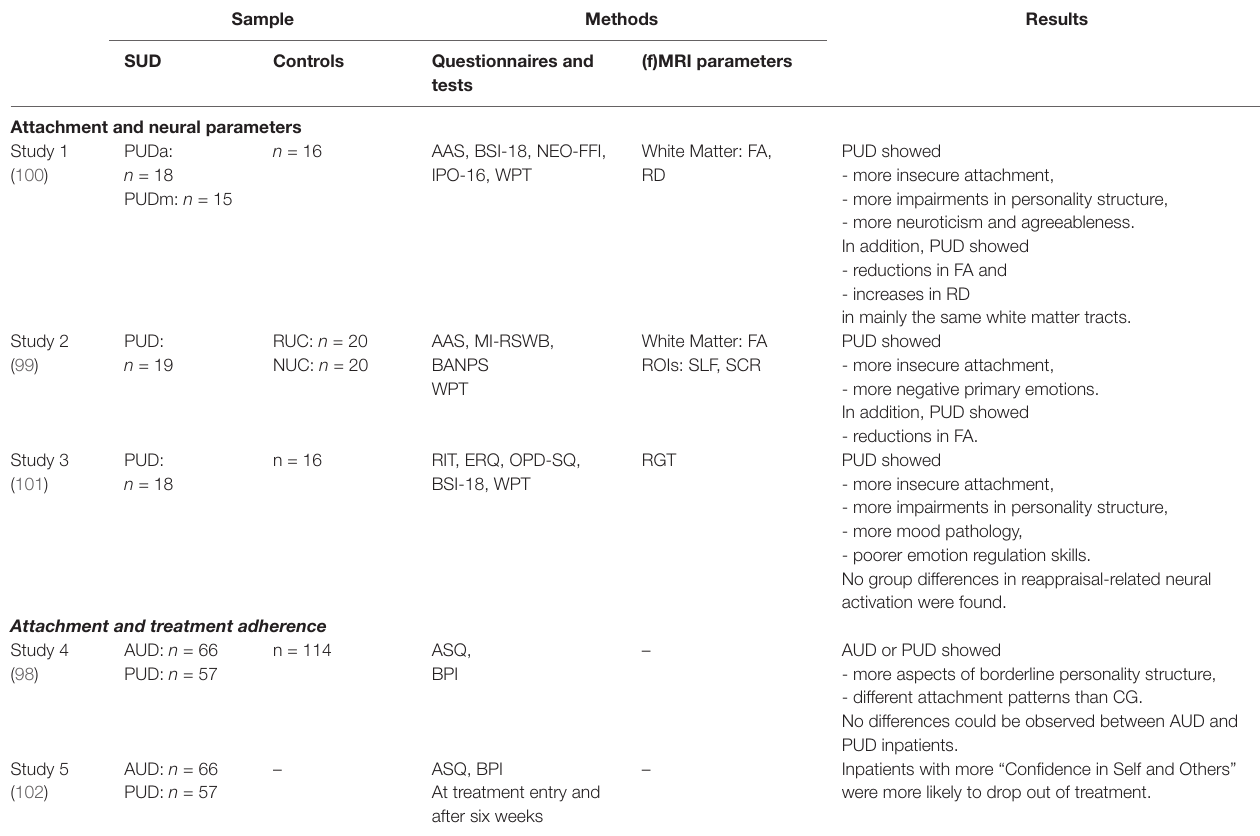
TABLE 1 | Methods and results of studies on